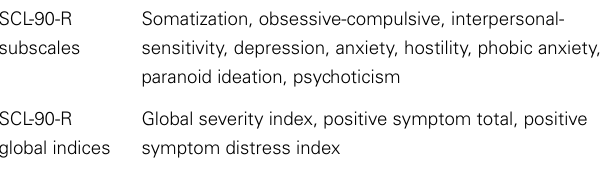
Table 5 | Symptom checklist-90-R subscales and global